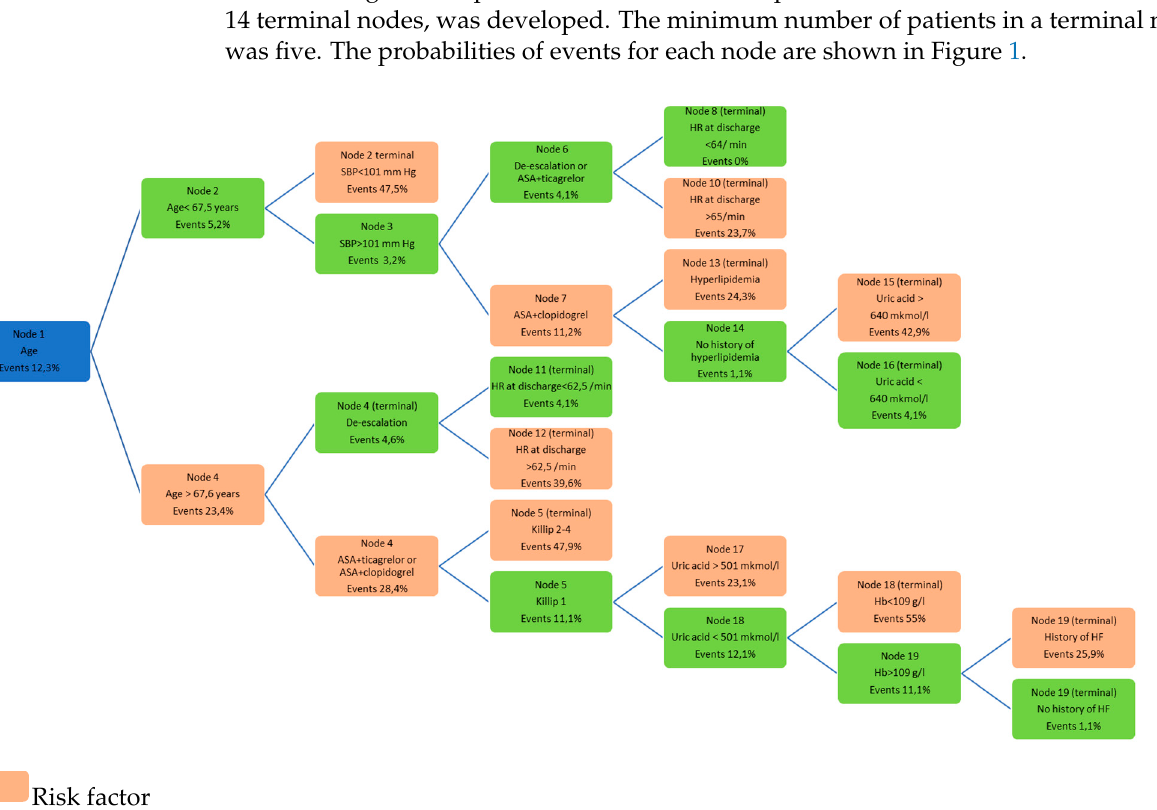
Figure 2. Relative prognostic significance of clinical predictors of all-cause mortality. The final model data were validated on the test cohort. The sensitivity of the model was 82.1% in the training cohort and 79.2% in test one. The area under the ROC curves in training and test cohorts did not practically differ (Figure 3).